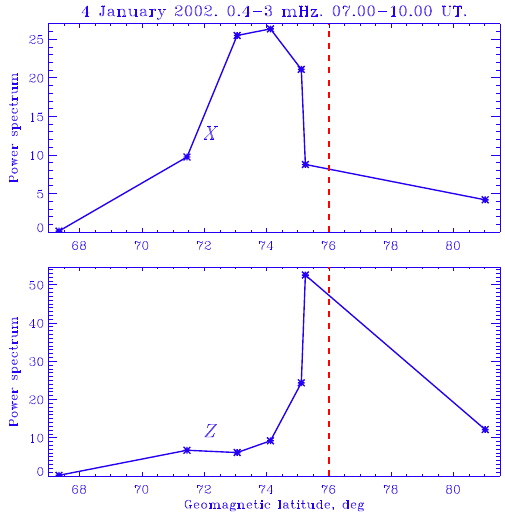
Figure 4. The latitudinal distribution of band-integrated (0.4– 1.7mHz) hourly spectral power in the IPCL band for the time in- terval 06:00 to 12:00UT 4 January 2002. The vertical dotted line (red) indicates the equatorward cusp boundary location.